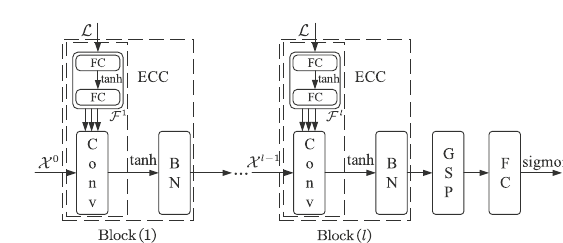
Fig. 1 Illustration of ECC on bus 1 of the IEEE 14-bus system Fig. 2 Structure of